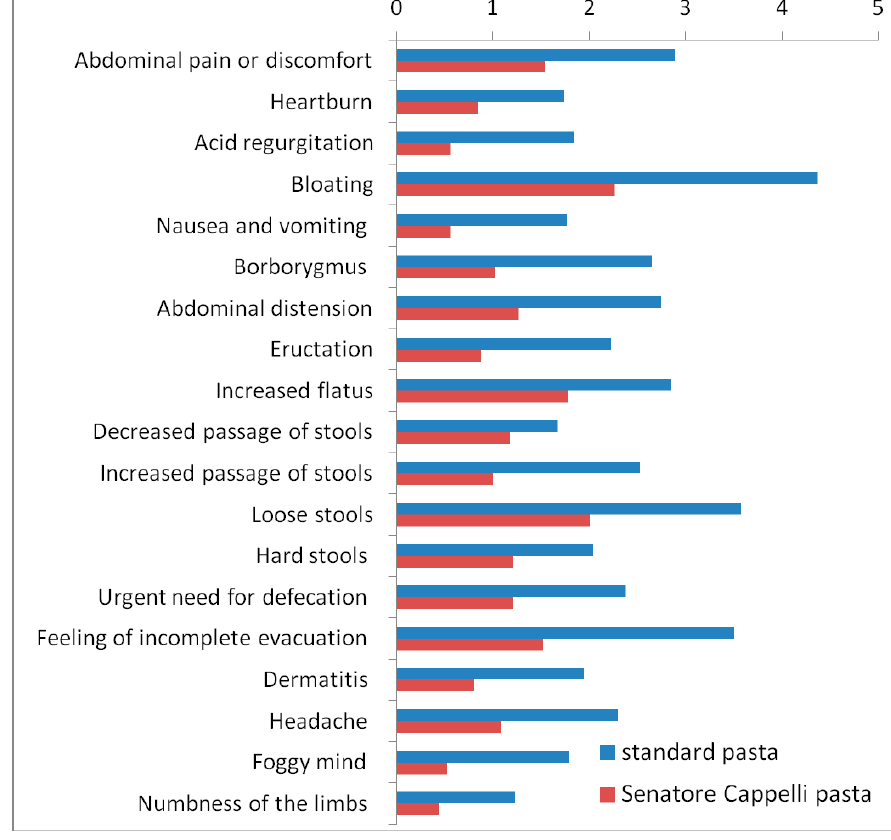
Figure 2. Scores for each item of the GSRS questionnaire.